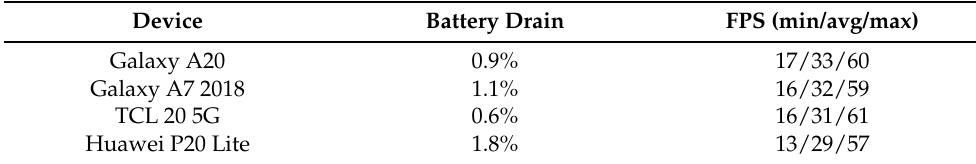
Table 1. Average results of 10 tests of 10 text question sessions.